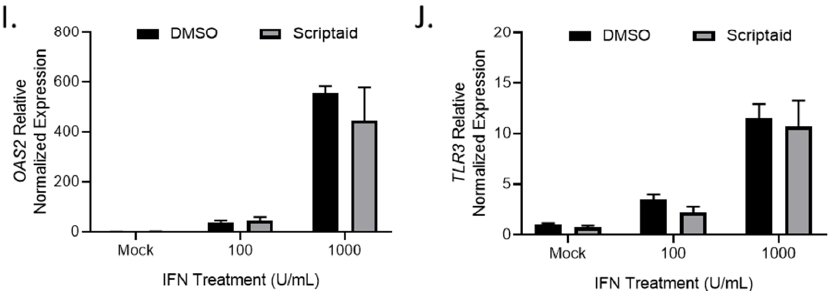
Figure 6. HDAC inhibitor pretreatment decreases P/V-CPI- induction of IFN-β and ISG expression. ( A – G ) H1299 ( A,C,E ) or A549 ( B,D,E ) cells were pretreated with 20 µM scriptaid or DMSO for 12 h. Cells were then mock infected or infected with P/V-CPI- at an MOI of 10 and cultured in media containing either 1 µM scriptaid or DMSO. At 24 hpi, media was collected and analyzed for IFN-β amounts by ELISA ( A,B ). Total cellular RNA was extracted and evaluated for IFIT1 ( C,D ) and OAS2 ( E,F ) expression levels by RT-qPCR. ( G ) H1299 cell lysates were analyzed for levels of IFIT protein by western blotting. ( H – J ) H1299 cells were pretreated with 20 µM scriptaid or DMSO for 12 h. Cells were then either mock treated or treated with 100 or 1000 U / mL of universal type 1 IFN. At 24 hpi, total cellular RNA was extracted and evaluated for IFIT1 ( H ), OAS2 ( I ), and TLR3 ( J ) expression levels by RT-qPCR. For all panels, error bars indicate standard deviation. ** and *** indicates p -values of < 0.01 and < 0.001,